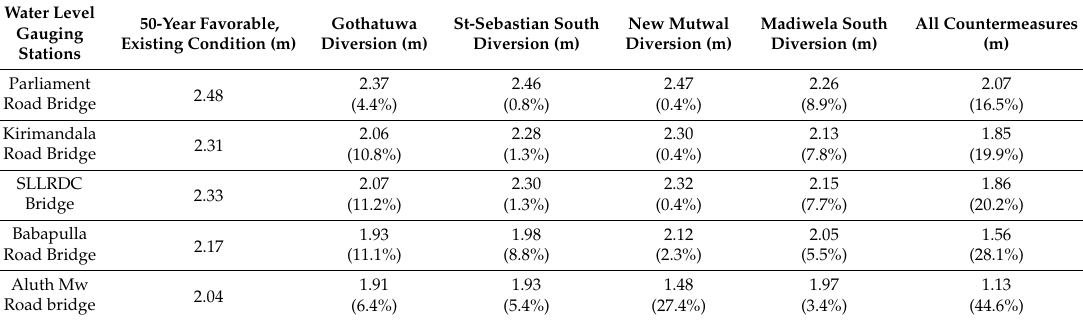
Table 6. Water level comparison of different countermeasures.